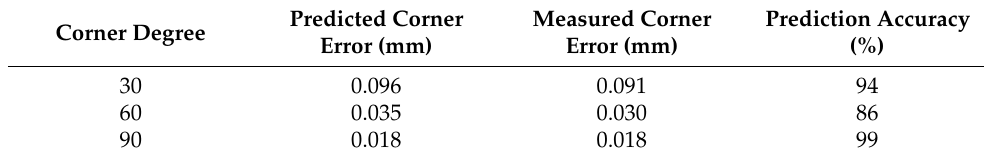
Table 13. Corner error using original parameter.